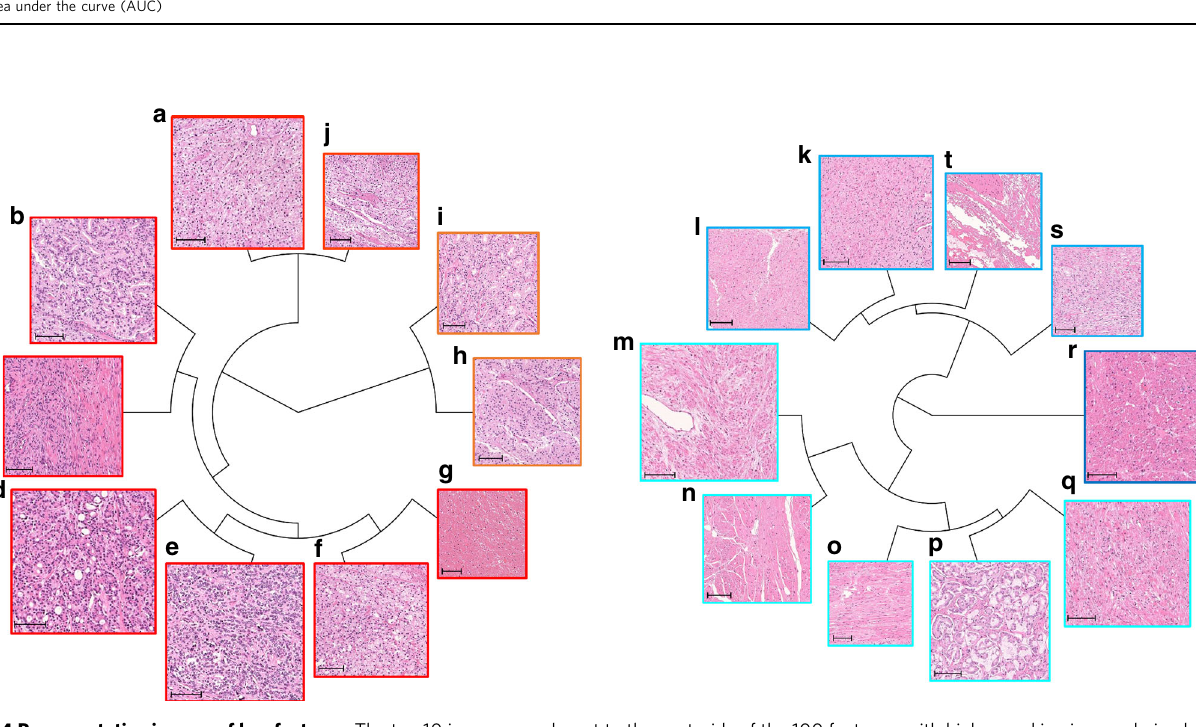
Fig. 4 Representative images of key features. The top 10 images are closest to the centroids of the 100 features, with higher-ranking images being larger, in the biochemical recurrence (BCR) group ( a – j ) and no BCR group ( k – t ). a – j Cancers equivalent to Gleason patterns 4 or 5, which usually indicate aggressive clinical behavior. c Dense stromal components without cancer cells. g Hemorrhage. p Cancers equivalent to Gleason pattern 3, which usually indicates benign clinical behavior. k – o , q – s Loose stromal components without cancer cells. t Surgical margin without cancer cells. The scale bar included in each image represents a length of 100 μ m. Expert genitourinary pathologist ’ s comments on BCR images ( a – j ): Cancers show Gleason patterns 4 or 5 indicating aggressive clinical behavior. Stromal component without cancer cells tends to show dense cellularity compared to those of normal structure. The pathologist ’ s comments on no BCR images ( k – t ): Cancers show Gleason pattern 3 indicating indolent clinical behavior. Stromal component without cancer cells tends to show relatively loose cellularity suggesting normal peripheral zone structure. Cauterized extraprostatic connective tissue without cancer cells, which indicate that the surgical margin is free from cancer.